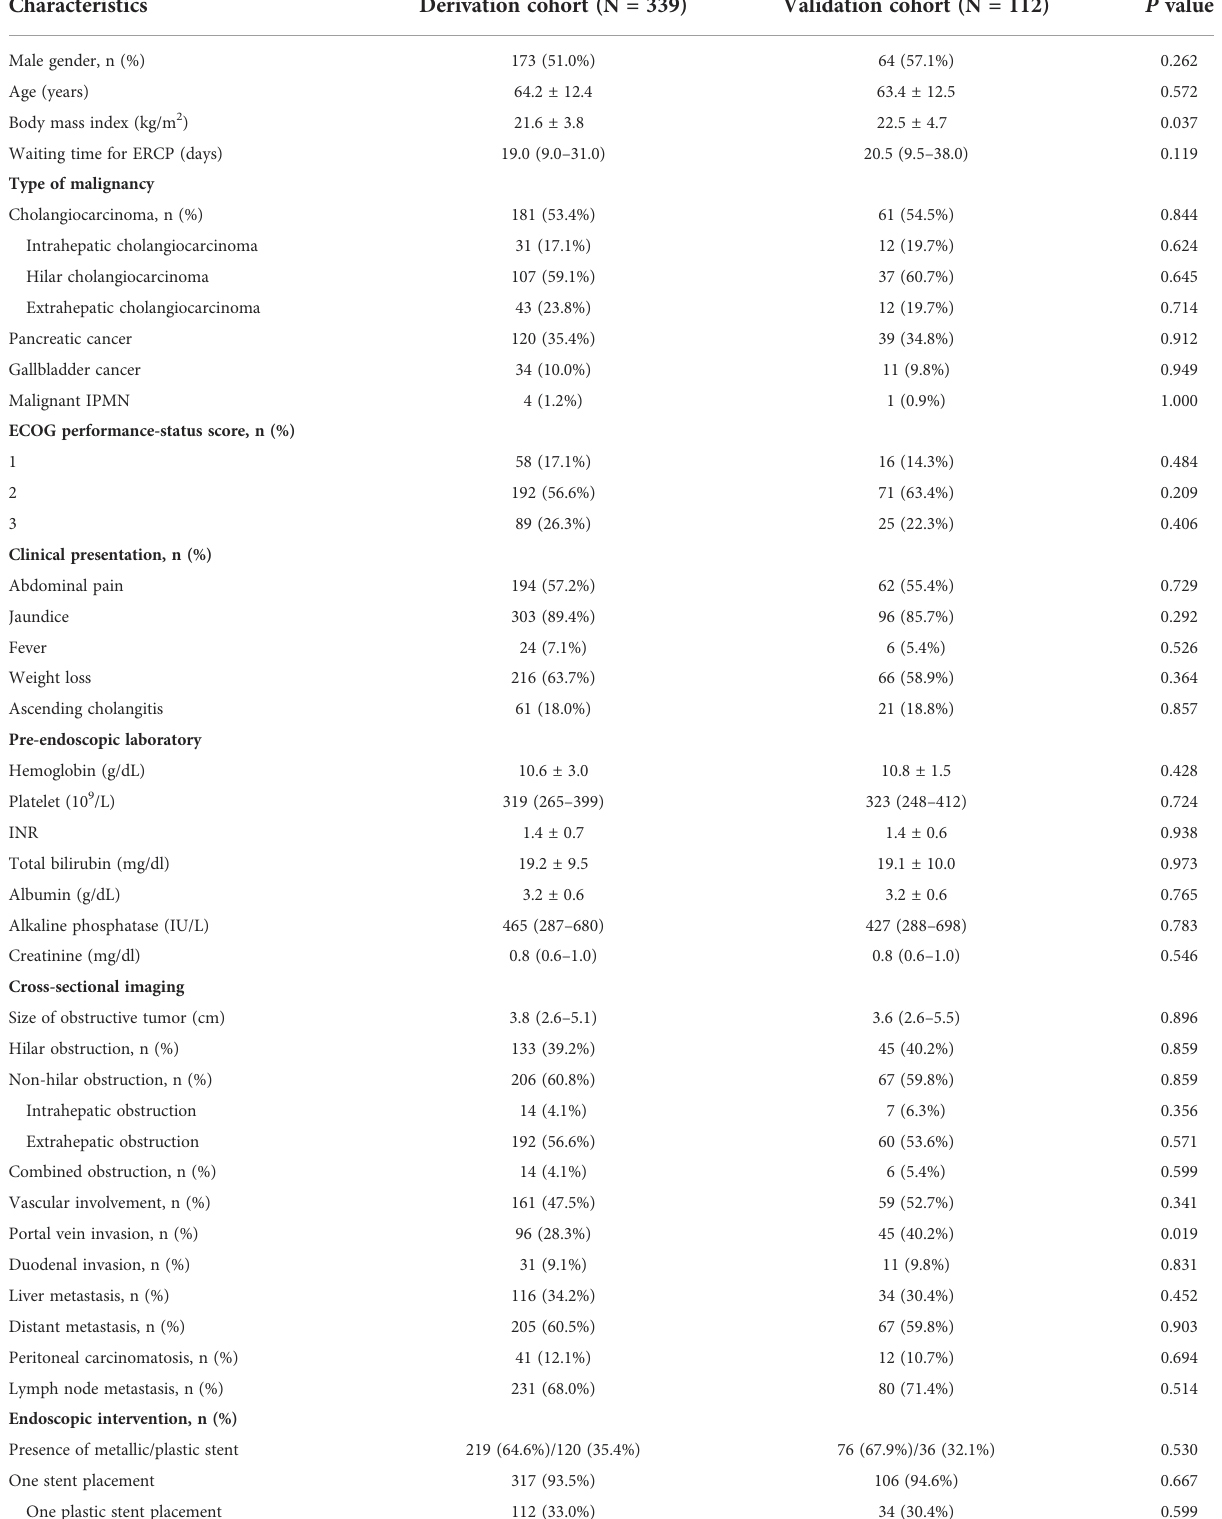
TABLE 1 Patient characteristics and endoscopic interventions in the derivation and validation cohorts.